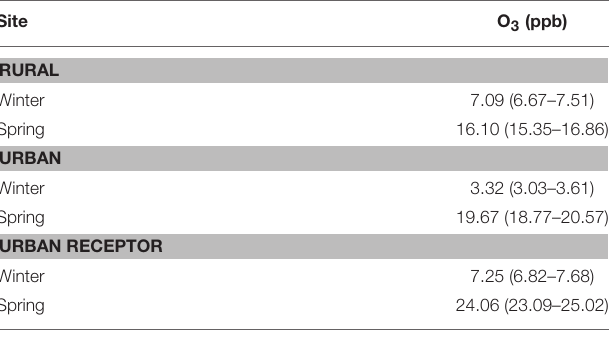
TABLE 4 | One-hour average ozone concentration.